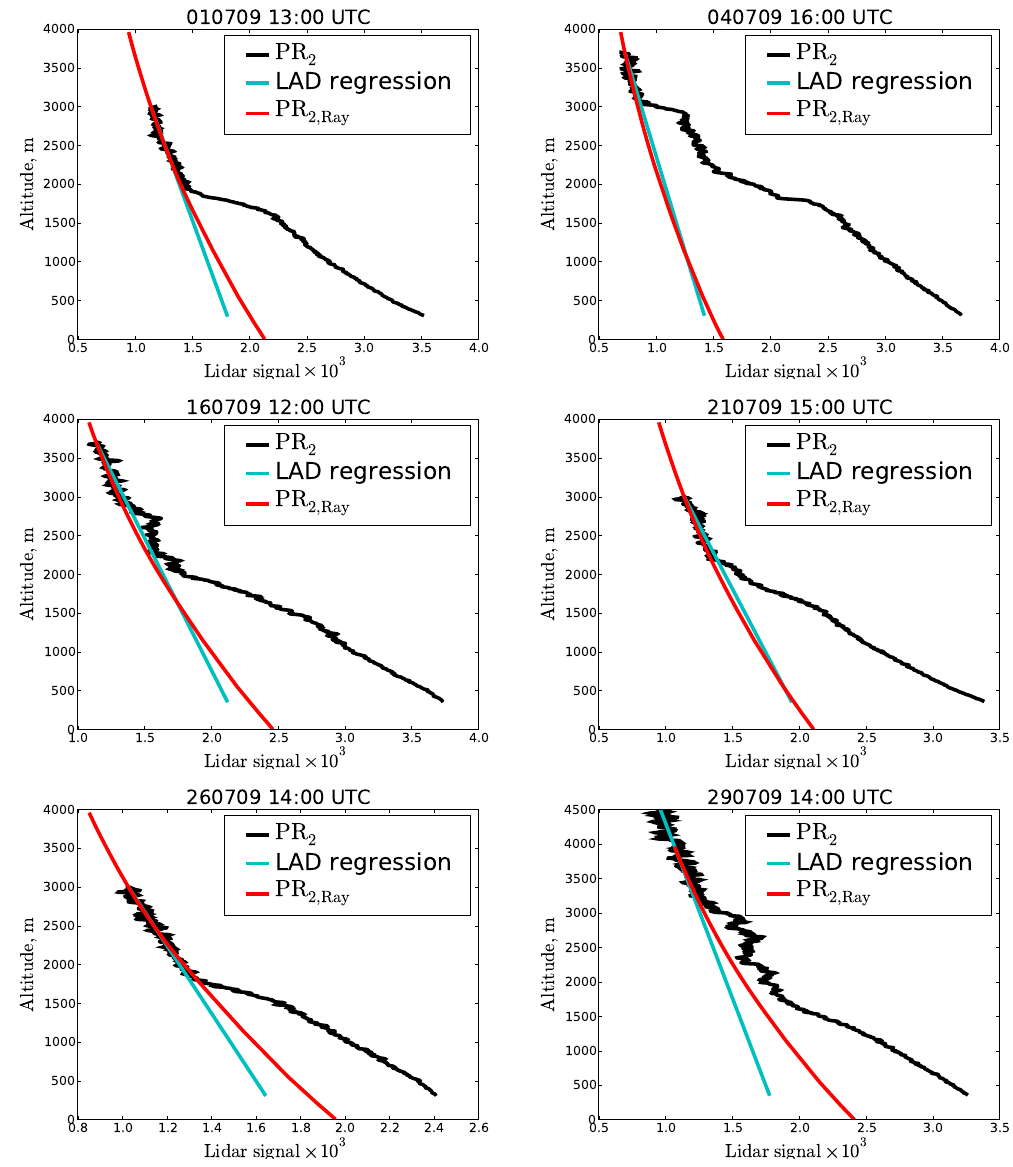
Fig. 3. Black lines (red lines) indicate lidar signals PR 2 (simulated molecular signals PR 2 , Ray ) at 13:00UTC, 1 July; 16:00UTC, 4 July; 12:00UTC, 16 July; 15:00UTC, 21 July; 14:00UTC, 26 July; and 14:00UTC 29 July 2009. LAD regressions of weighted lidar measurement points are indicated by cyan